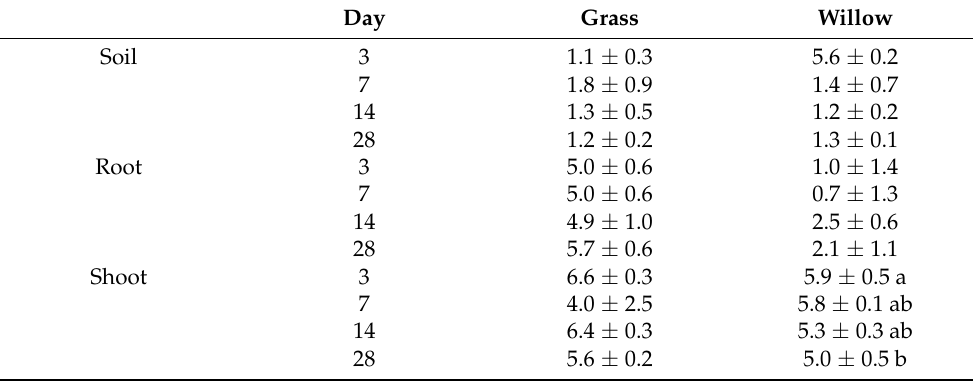
Table 4. Enrichment with 13 C [log( ∆ 13 C + 2) in‰ ± s.d.] in basal food web resources, i.e., the tissues of grass and willow, and the soil underneath at day 3, 7, 14 and 28 after 13 CO 2 labeling. Values with no or the same letter are not significantly different according to Tukey’s HSD test at p < 0.05. Letters denote significant differences between ∆ 13 C between the four sampling days for each basal resource of grass and willow.